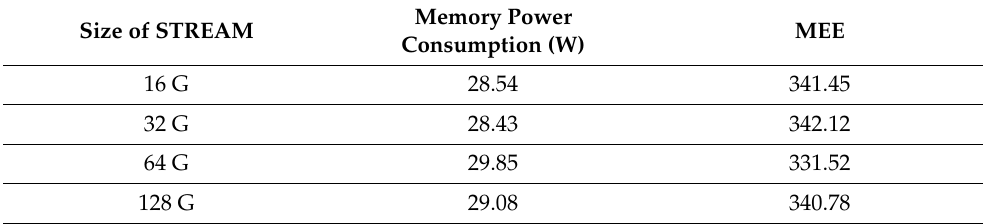
Table 6. Experimental results of different STREAM array sizes under SMP